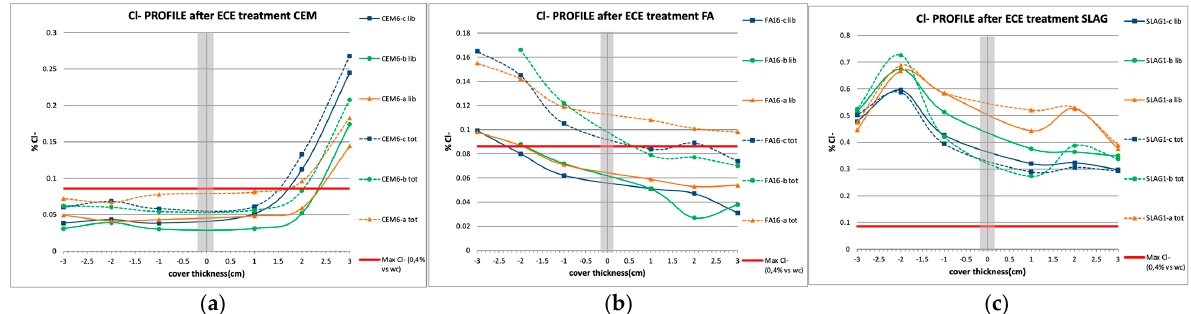
Figure 12. Chloride profiles determined in specimens after the ECE treatment. ( a ) CEM I specimens; ( b ) FA specimens; ( c ) SLAG specimens.